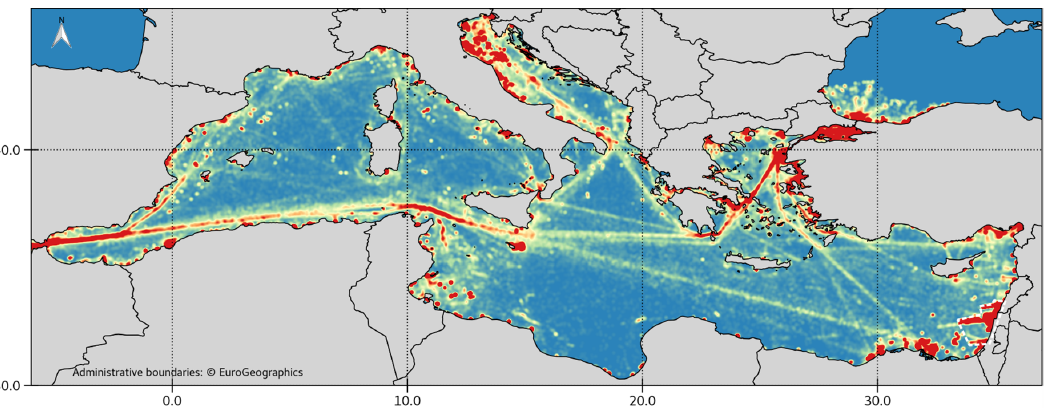
Figure 8. Density map of all the reliable detections (608,326). Area off Israel with high concentration of Figure 8 . Density map of all the reliable detections (608,326). Area off Israel with high concentration Figure 8 . Density map of all the reliable detections (608,326). Area off Israel with high concentration Figure 8 . Density map of all the reliable detections (608,326). Area off Israel with high concentration RFI-related detections is indicated as a white polygon. of RFI-related detections is indicated as a white polygon. of RFI-related detections is indicated as a white polygon. of RFI-related detections is indicated as a white polygon.